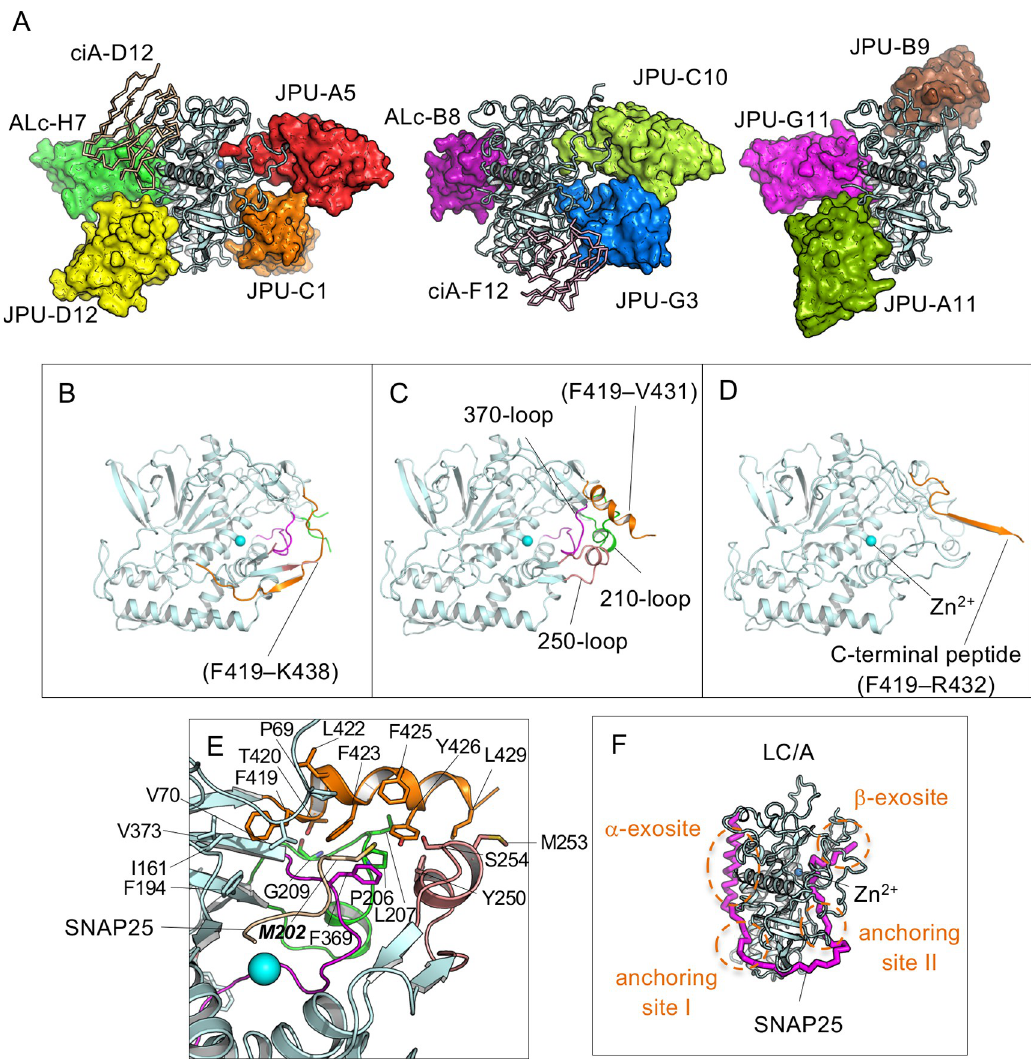
Fig 1. Overall structures of VHHs in complex with LC/A. (A) Structures of LC/A–VHH complexes. Inhibitor VHHs are represented in surface. Non-inhibitor VHHs (ciA-D12 and ciA-F12) are shown as ribbon. Duplicated VHH structures are omitted from the figure for clarity. (B–D) The structures of the JPU-B9-bound fLC/A (B), and the JPU-C10-bound fLC/A (C), and LC/A in BoNT/A holotoxin (PDB code 3BTA) (D). The 210-, 250-, 370-loops and C-terminal-peptide of LC/A are highlighted in green, pink, magenta, and orange, respectively. (E) Superposition of the JPU-C10-bound fLC/A with SNAP25(197– 202)-bound LC/A (PDB code: 3DDA) highlighting the potential interaction between the C-terminal residues of fLC/A with P5’ M202 (shown as stick) of SNAP25. LC/A is colored as that shown in (B–D) while a short SNAP25 peptide is colored wheat. The interacting residues between the C-terminal peptide with the surrounding loops on LC/A are drawn as sticks. (F) The structure of the LC/A–SNAP25(146–204) complex (PDB ID: IXTG), where SNAP25 is shown as a purple ribbon model. The approximate regions of the α - and β -exosites and the anchoring sites I and II are indicated by dotted